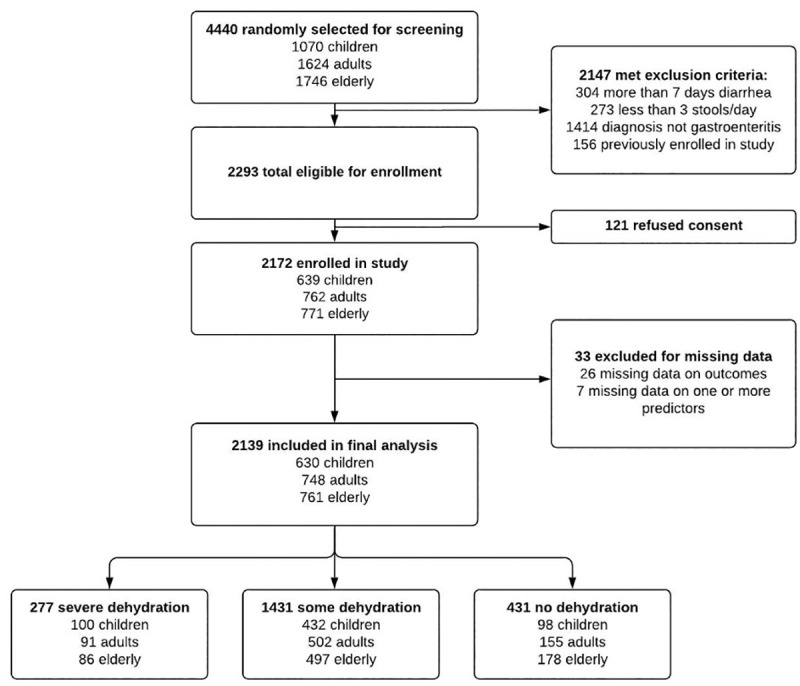
Patient Enrollment.